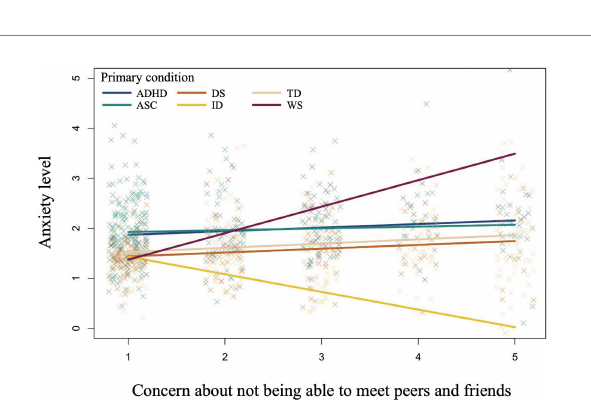
FIGURE 5 Three-way interaction for individual’s primary condition, concern for loss of routine and anxiety. Anxiety and concerns are measured with a 5-point Likert scale from 1 (not anxious/not concerned at all) to 5 (very anxious/extremely concerned). The level of anxiety and concern of individuals with NDCs and TD siblings was reported by their parents or caregivers. NDCs = neurodevelopmental conditions, ADHD = attention deficit disorder (with or without hyperactivity), ASC = autism spectrum condition, DS = Down syndrome, ID = intellectual disability, WS = Williams syndrome, TD = typically developing.